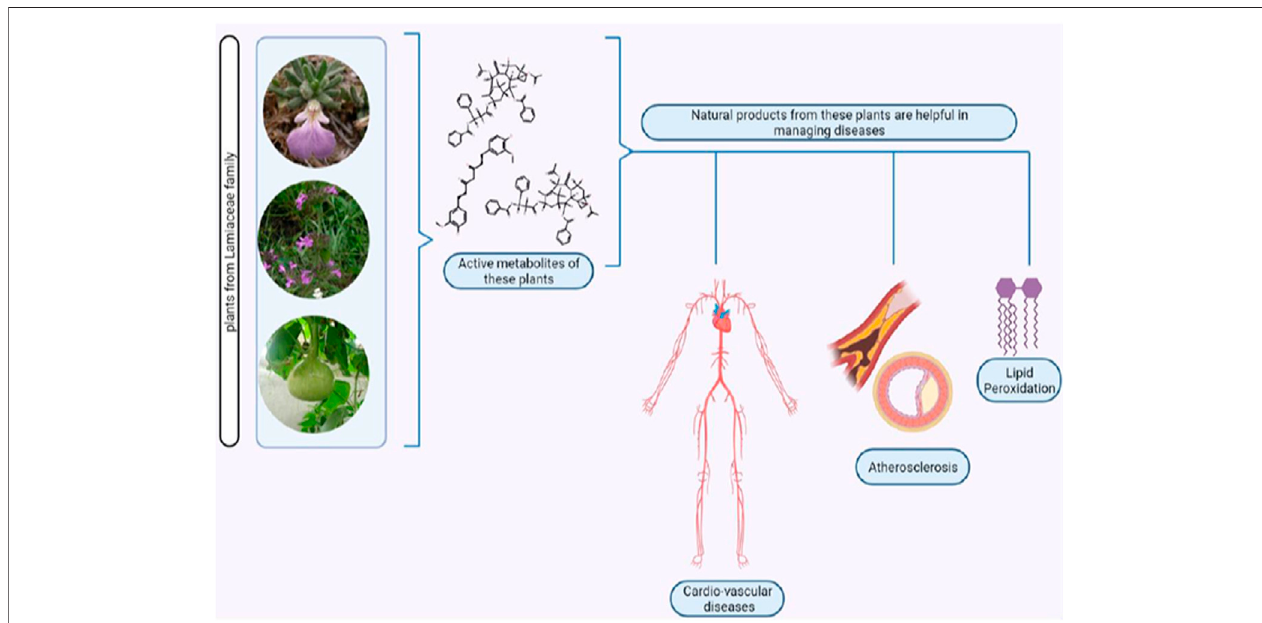
FIGURE 2 | Exploration of Lamiaceae bioactive natural products on CVD (Figure Made in BioRender.com).